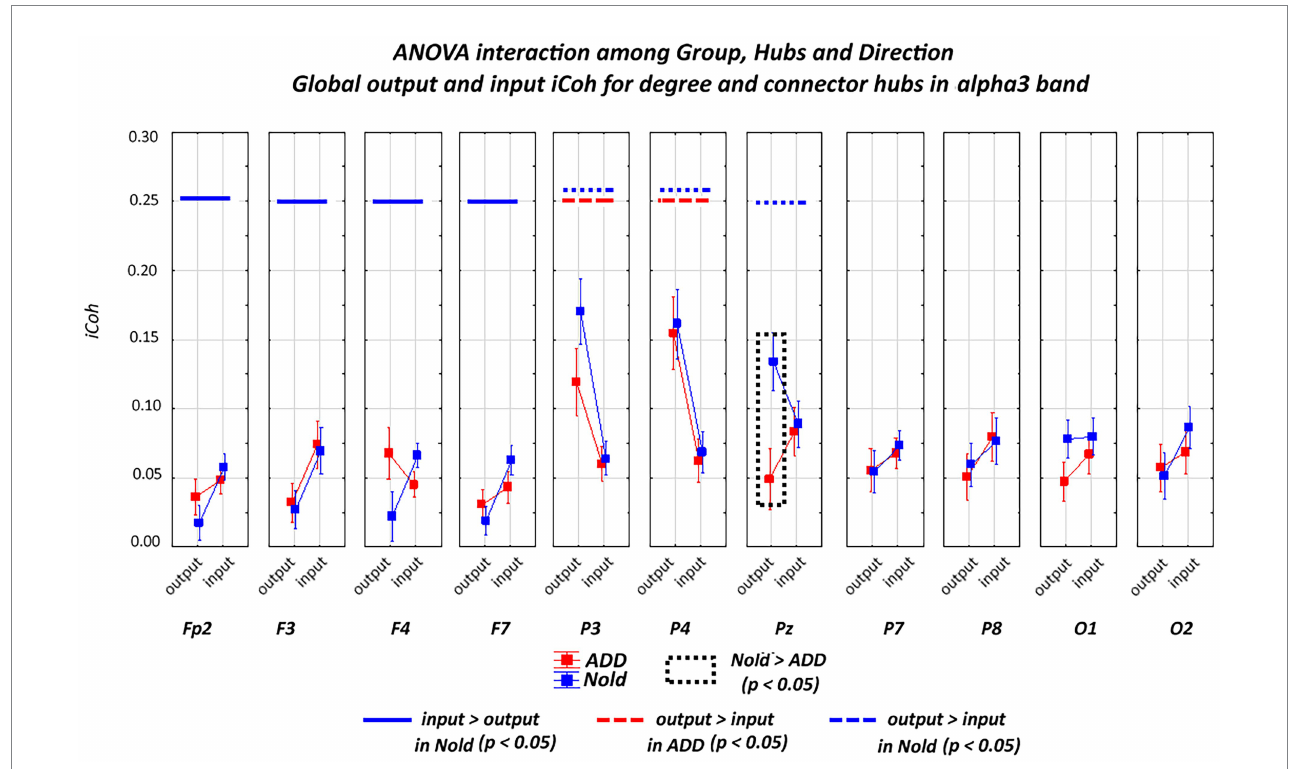
FIGURE 6 Global isolated lagged effective coherence (iCoh) values (mean across subjects ± SEM) in the alpha 3 frequency band within electrodes classified as substantial degree or connector hubs relative to a statistically significant ANOVA interaction (F [10, 750] = 2.48, p < 0.05) among the group (Nold and ADD), hubs (Fp2, F3, F4, F7, P3, P4, Pz, P7, P8, O1, and O2), and direction (output and input) factors. No statistically significant outliers were found according to Grubbs’ test ( p <